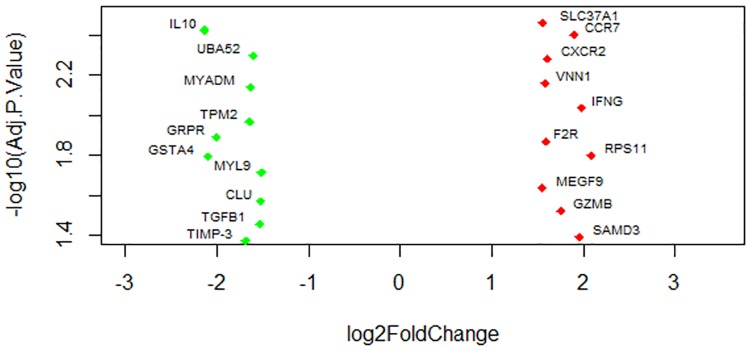
Volcano plot showing the most significantly altered genes at day 28 post vaccination.The picture demonstates the range of fold changes of most significantly altered transcripts in connection to adaptive immune response in PBMCs.